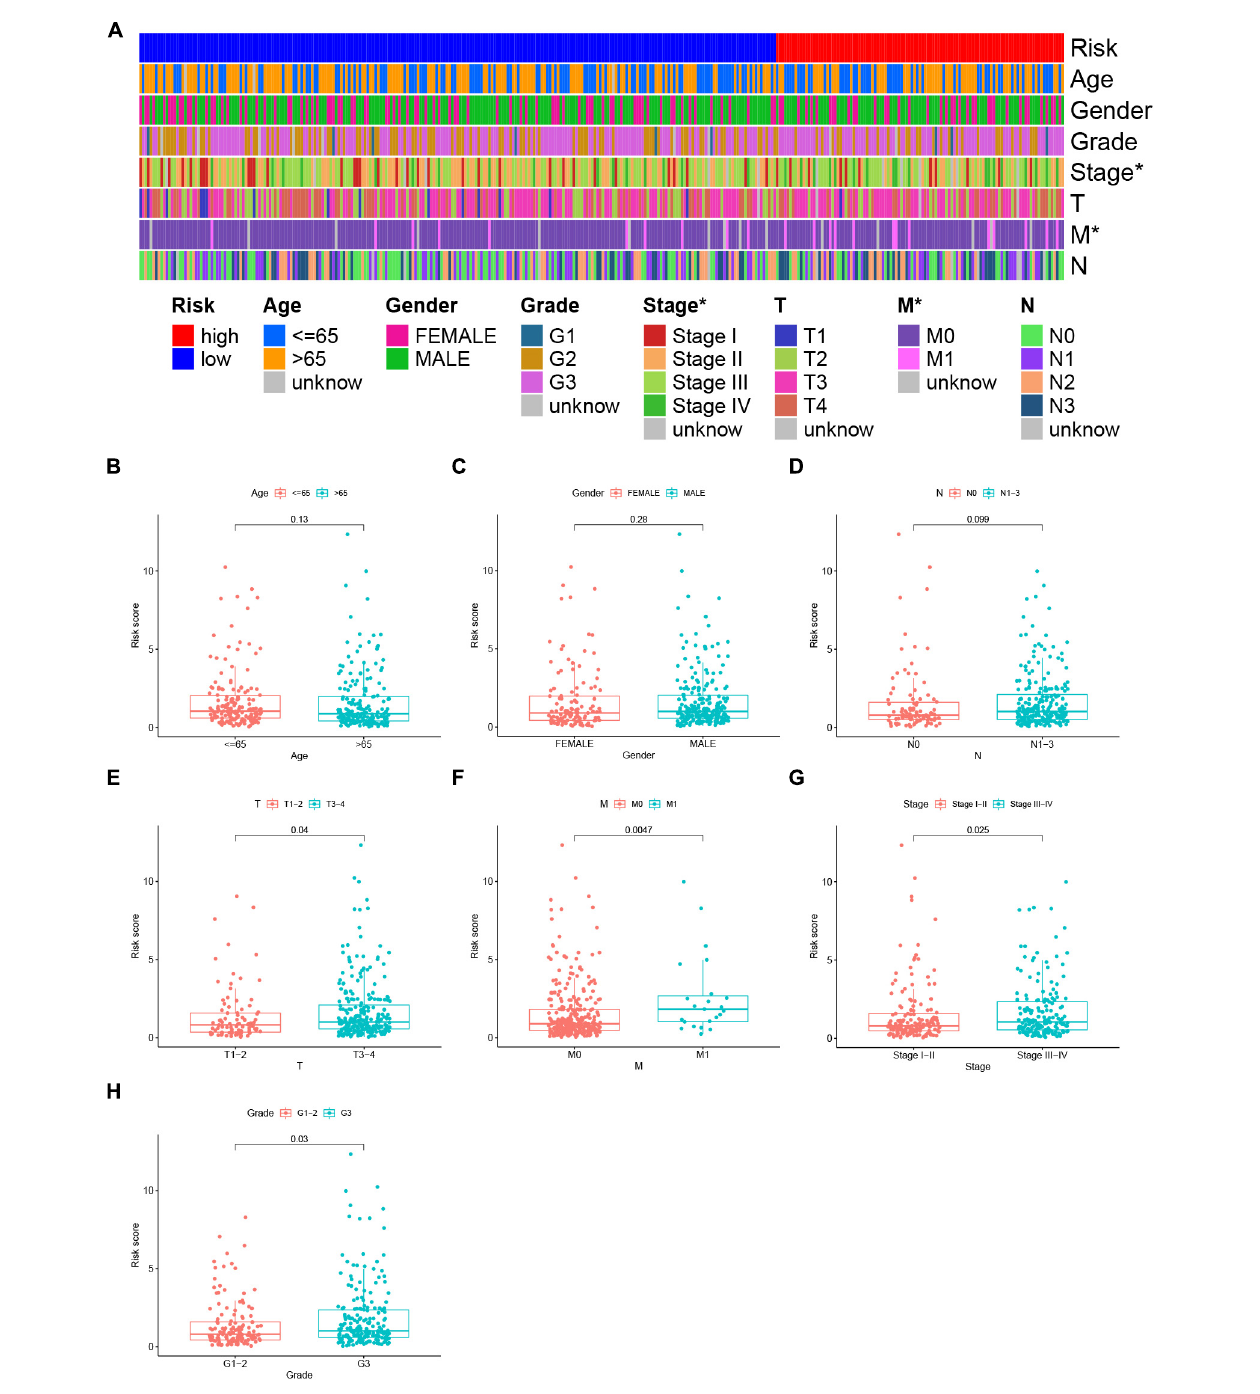
FIGURE 5 | Correlation of the clinical features and IRlncRNAPs signature. (A) Heat map showing the distribution of clinical features between the high- and low-risk groups. The riskScores in different (B) age, (C) gender, (D) N stage, (E) T stage, (F) M stage, (G) clinical stage, and (H) tumor grade groups for GC patients. * P <